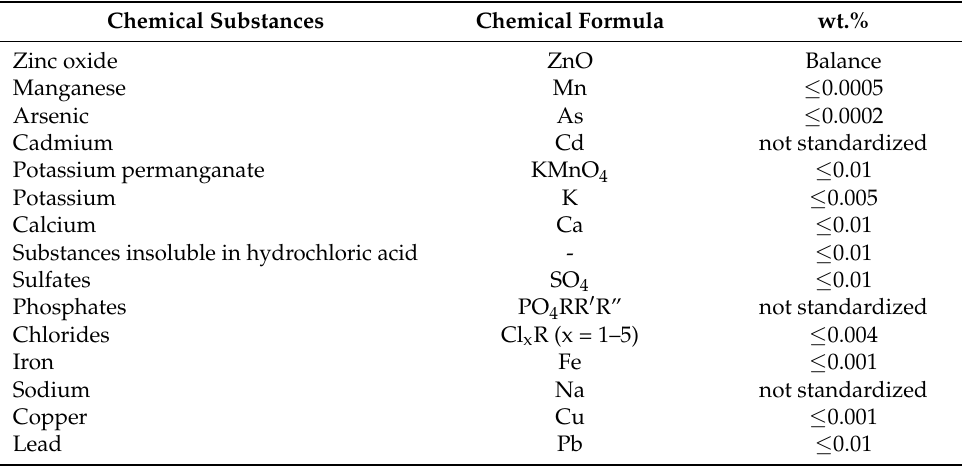
Table 3. Chemical composition of ZnO powder (“Ch” grade, 99% of